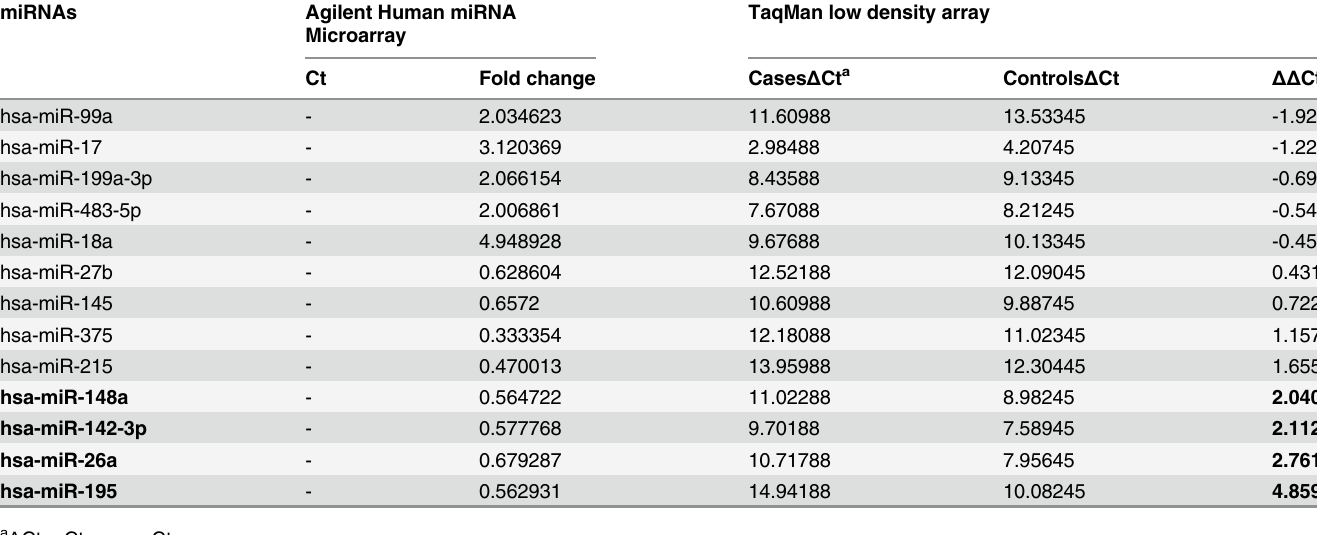
Table 2. The comparison of the partly results of microarrays.